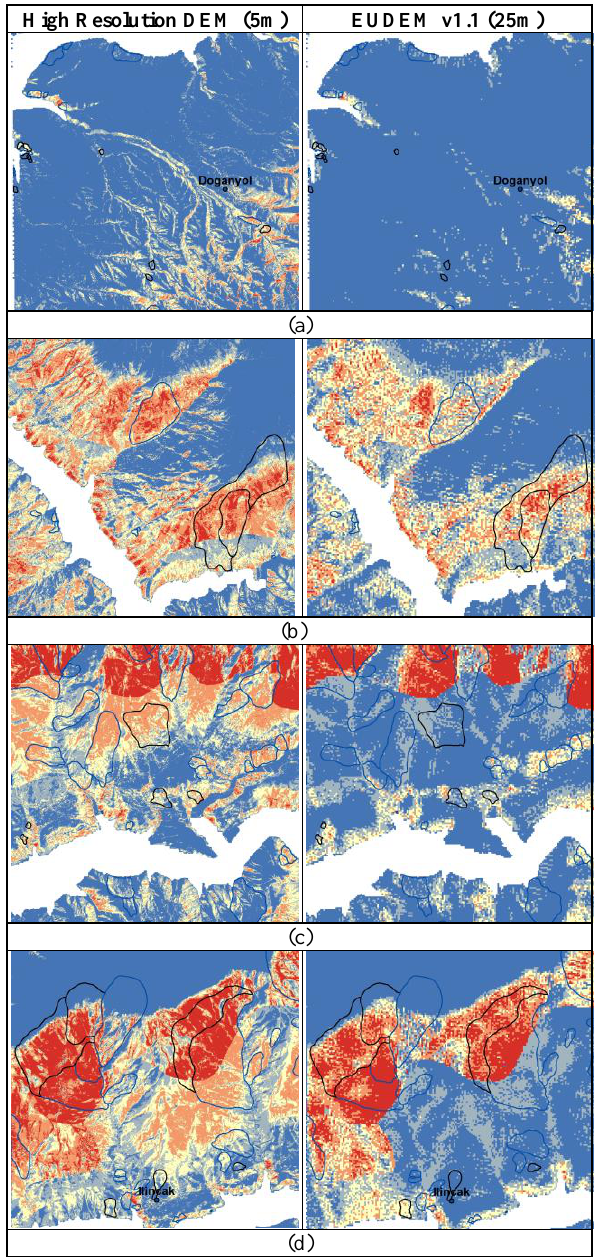
Figure 8 . Parts of the LSMs obtained using the aerial DEM (left) and EUDEM v1.1